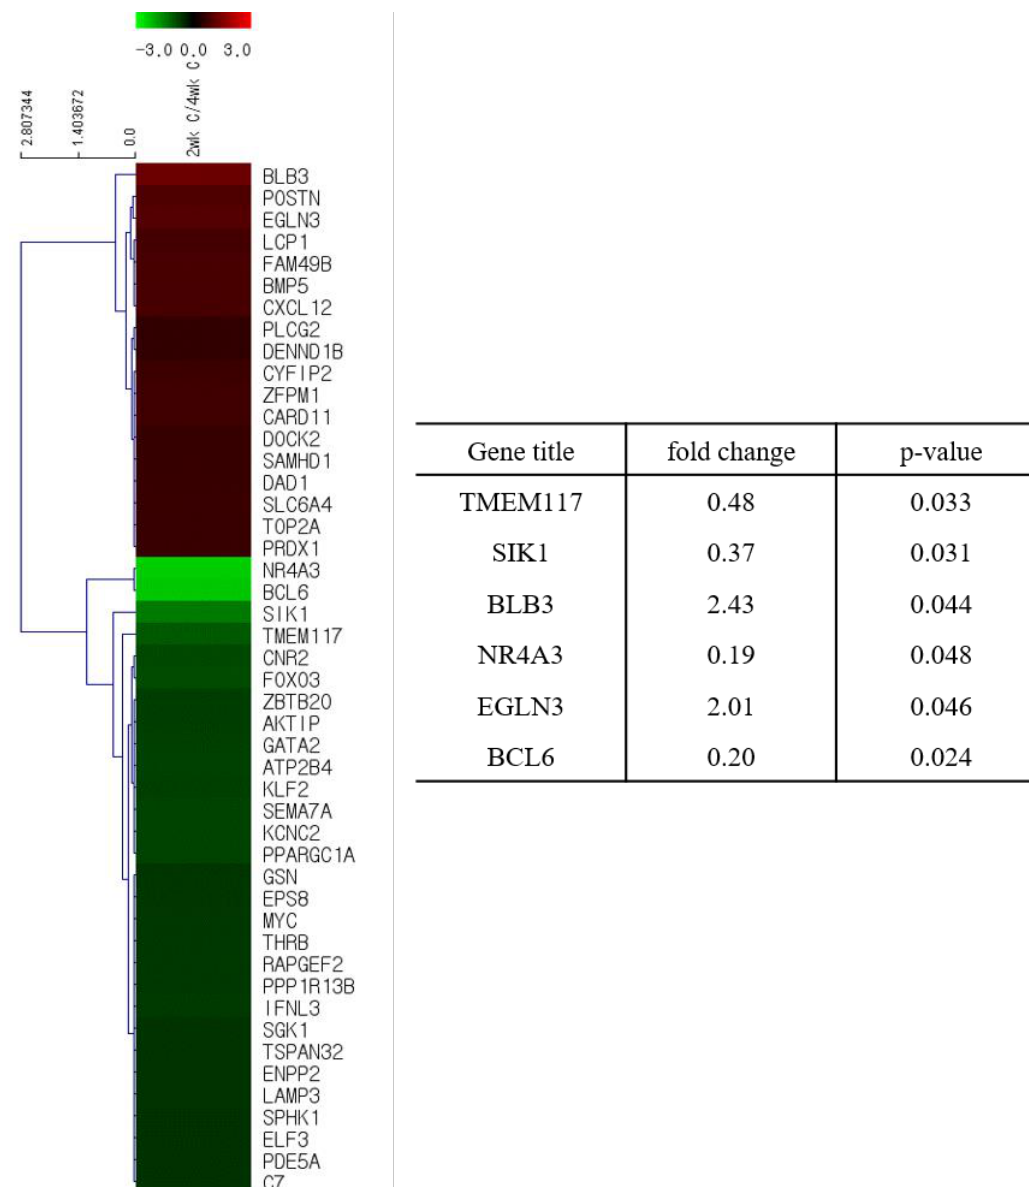
Figure 3. Heat maps and the fold change of differentially expressed genes in the lung of PBS-mock infected ducks. Total RNA was collected from one gram of lung tissue from ducks. The purified RNA was used for microarray using a chicken DNA chip: The differentially expressed genes in the lungs of a 2-week-old duck compared to those in the lungs of a 4-week-old duck.